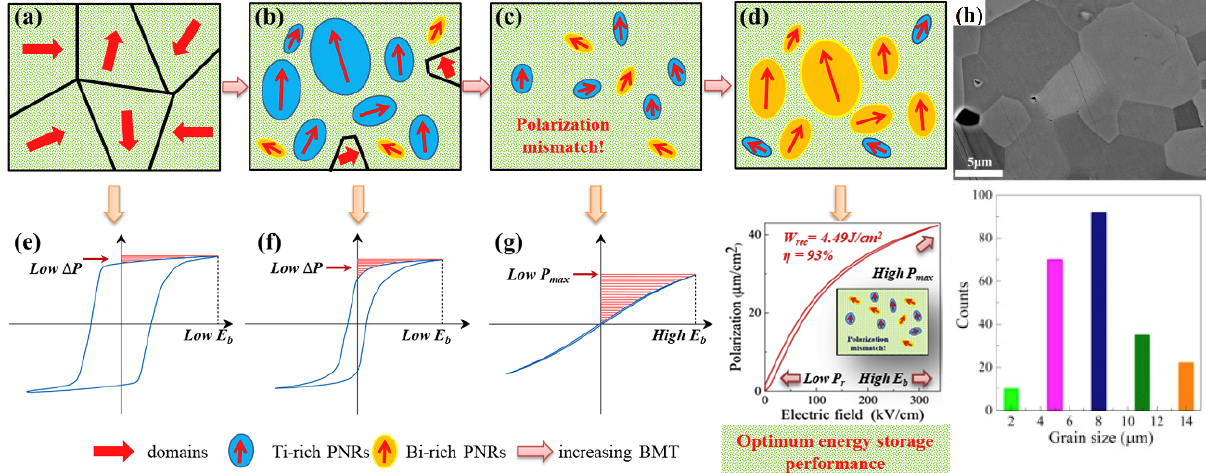
Fig. 5 (a–g) Schematic diagram of the nano-scale polarization mismatch and reconstruction strategy. (h) SEM image for 0.6BT–0.4BMT ceramic and the grain size distribution. Reproduced with permission from Ref. [38], © Elsevier Ltd. 2019.